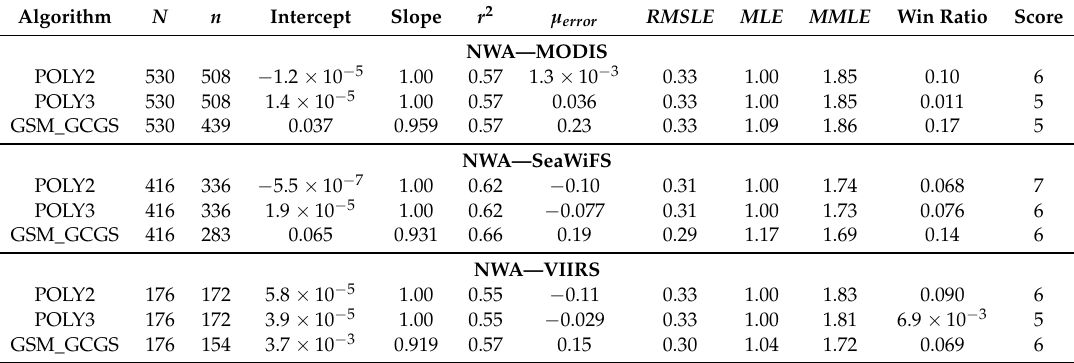
Table A1. Statistics of extra algorithms not presented in the text, as in Tables 3 and